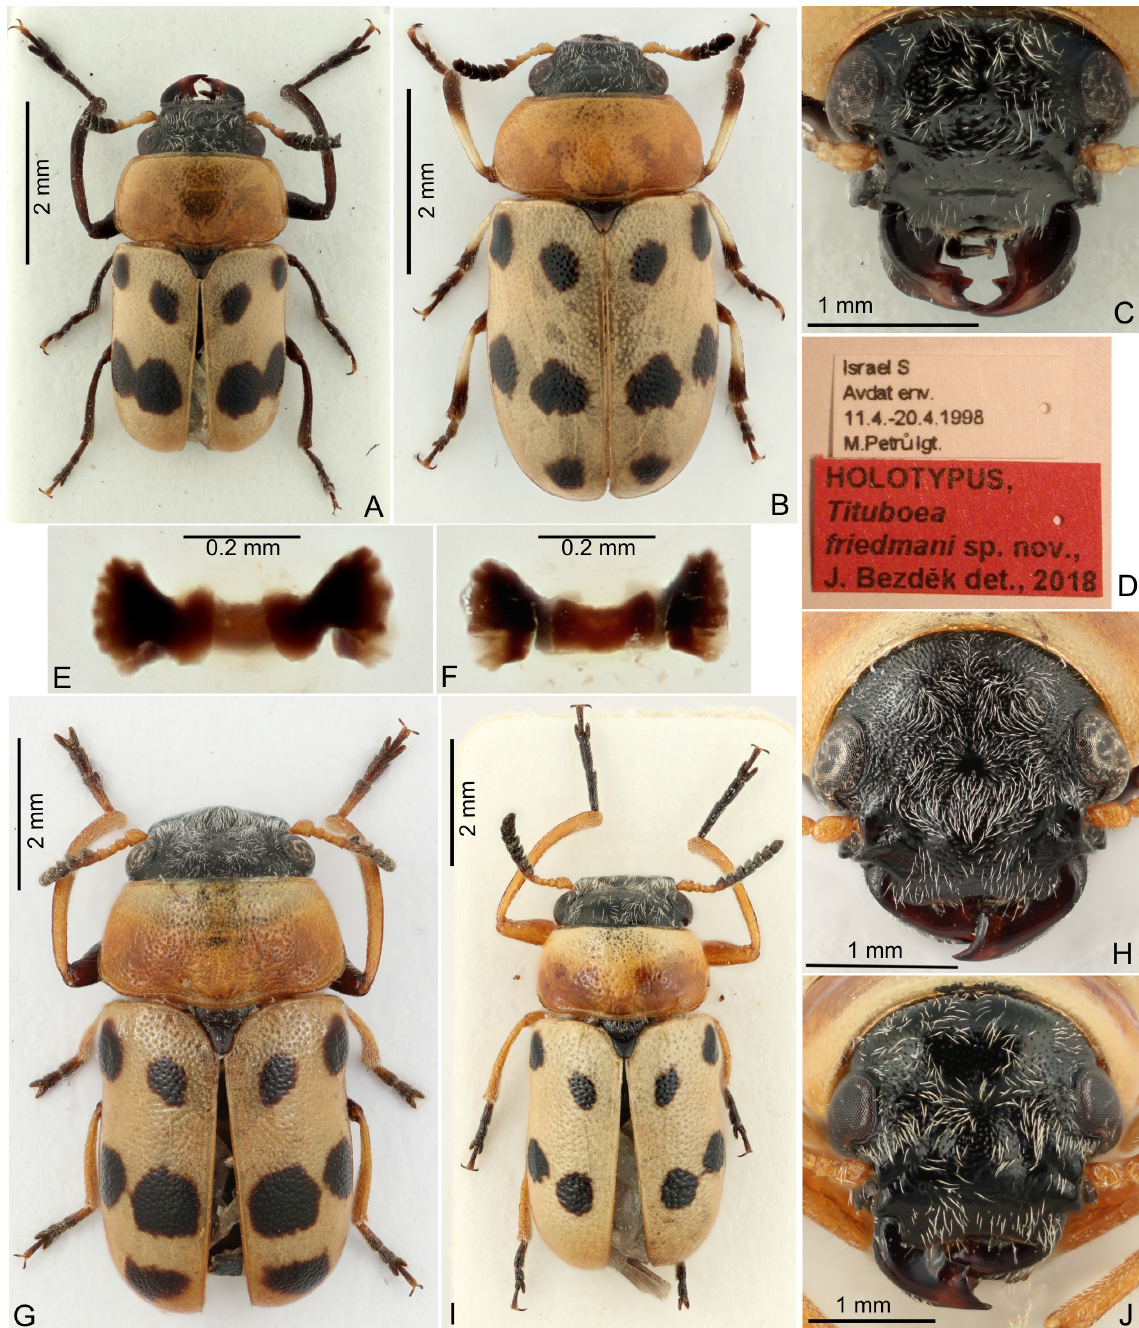
Fig. 4. A – F . Tituboea friedmani Bezděk sp. nov. A . Holotype, ♂, 4.8 mm (NMPC). B . Paratype, ♀, 4.6 mm (TAU). C . Male head. D . Labels of holotype. E . Kotpresse, ventral sclerites. F . Kotpresse, dorsal sclerites. G – H . T. chobauti (Pic, 1896). G . ♂, 6.1 mm. H . Head. I – J . T. atriceps Pic, 1924. I . ♂, 6.0 mm. J .